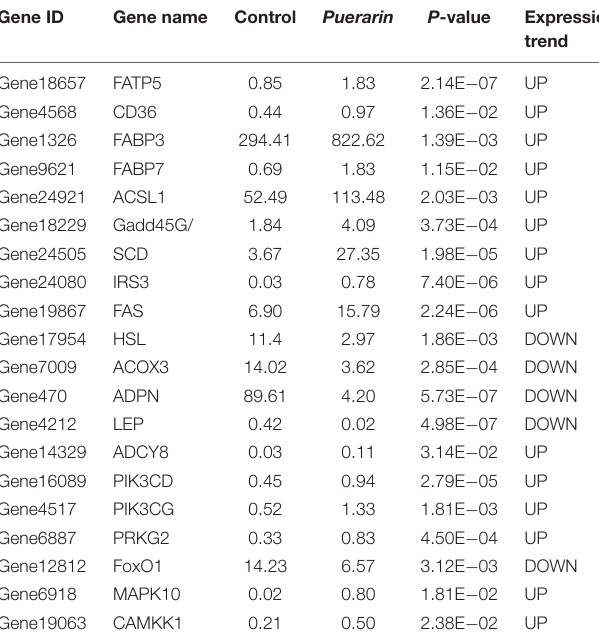
TABLE 7 | Differentially expressed genes related to lipid metabolism. TABLE 8 | Classification of DEG according to the KEGG pathways enrichment